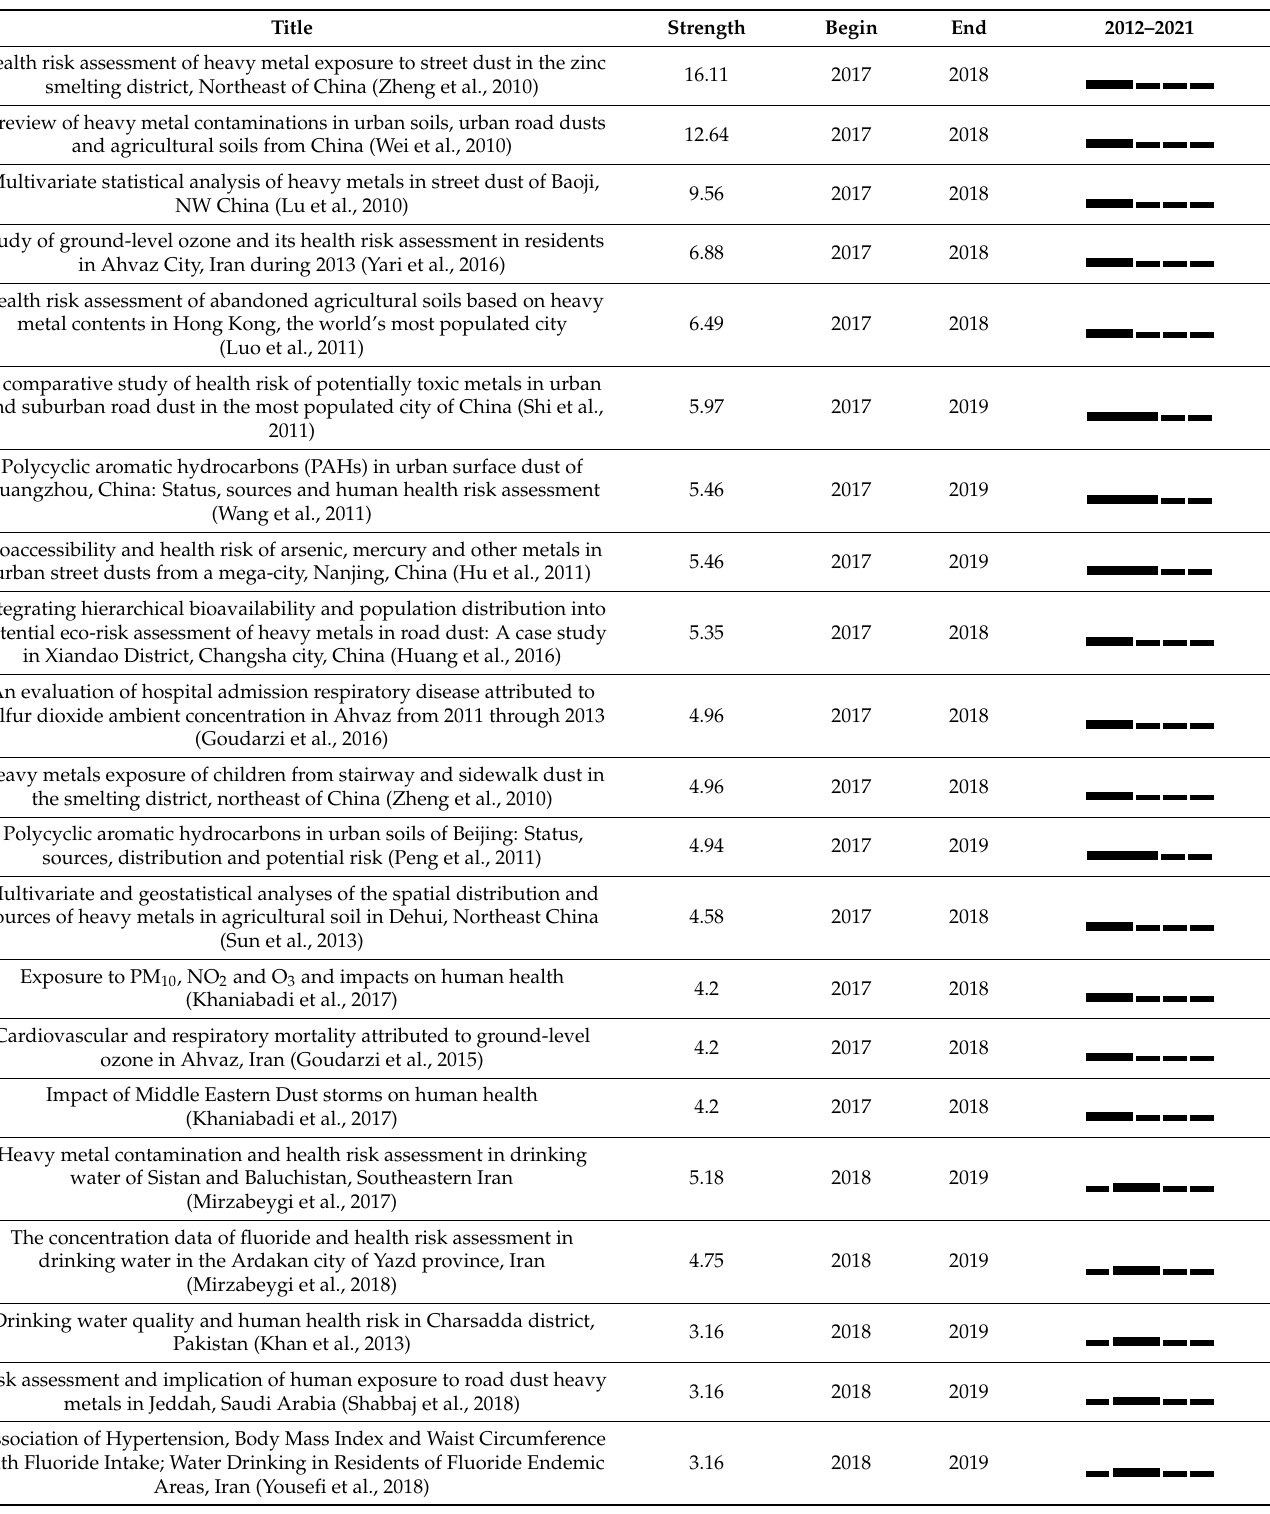
Table 8. Top 30 references with strongest citation bursts in 2017–2021. The black line represents the year of citation burstness of the